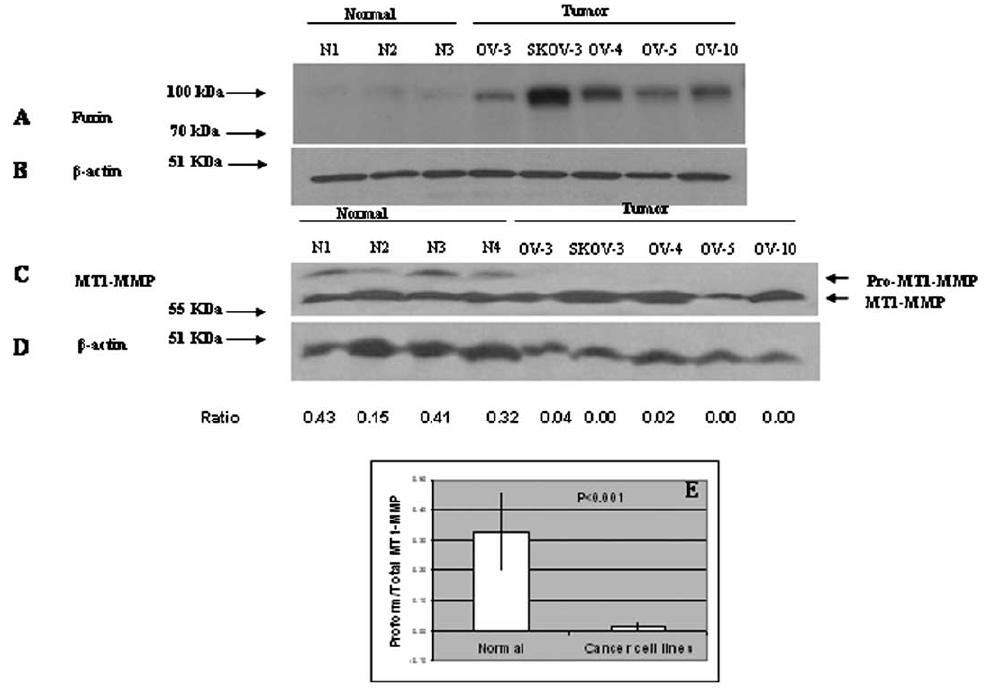
Fig. 2. Furin expression in normal or cancer cell lines. Cell lysates (100 µ g) were fractionated with a 10% PAGE-SDS gel. (A,B): Furin expression and its corresponding loading control ( β -actin), respectively. Note furin expression in cancer cell lines but not in cells derived from normal surface epithelium. (C,D): MT1-MMP processing in normal or cancer cell lines (C) and its loading control ( β -actin) (D). Note complete processing in cancer cell lines. (E): Increased MT1-MMP processing in furin-expressing cancer cell lines. Average of the ratio proform/total MT1-MMP in normal cells and cancer cell